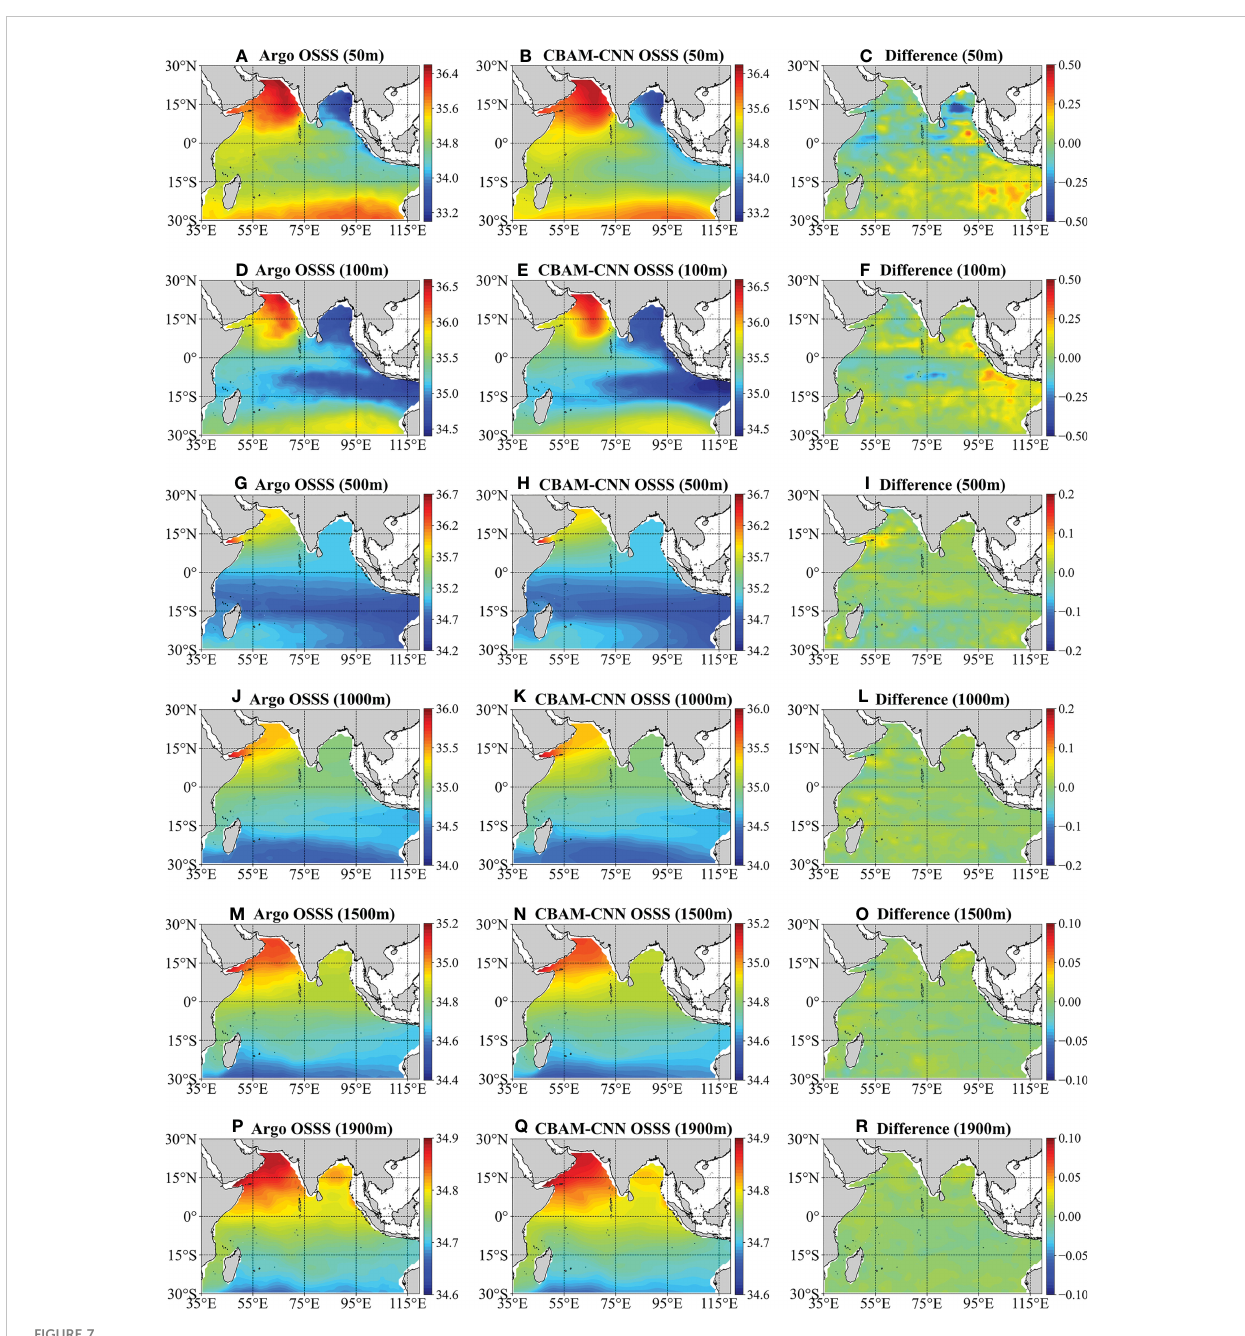
FIGURE 7 Same as Figure 6, but for